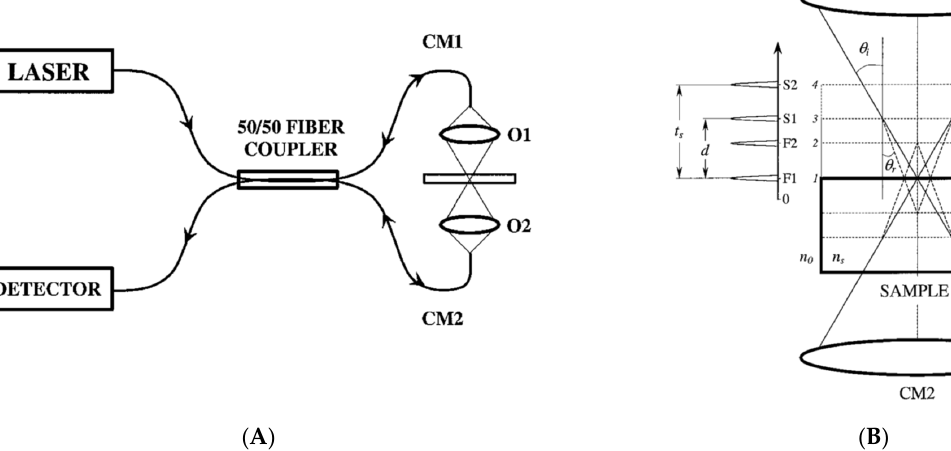
Figure 8. ( A ) Optical configuration of the dual confocal fiber optic system and ( B ) its operating prin ‐ ciple by the ray model (reprinted/adapted with permission from [56] © The Optical Society); LASER, He–Ne laser (632.8 nm); O1, O2, confocal focusing objectives; CM1, CM2, first and second